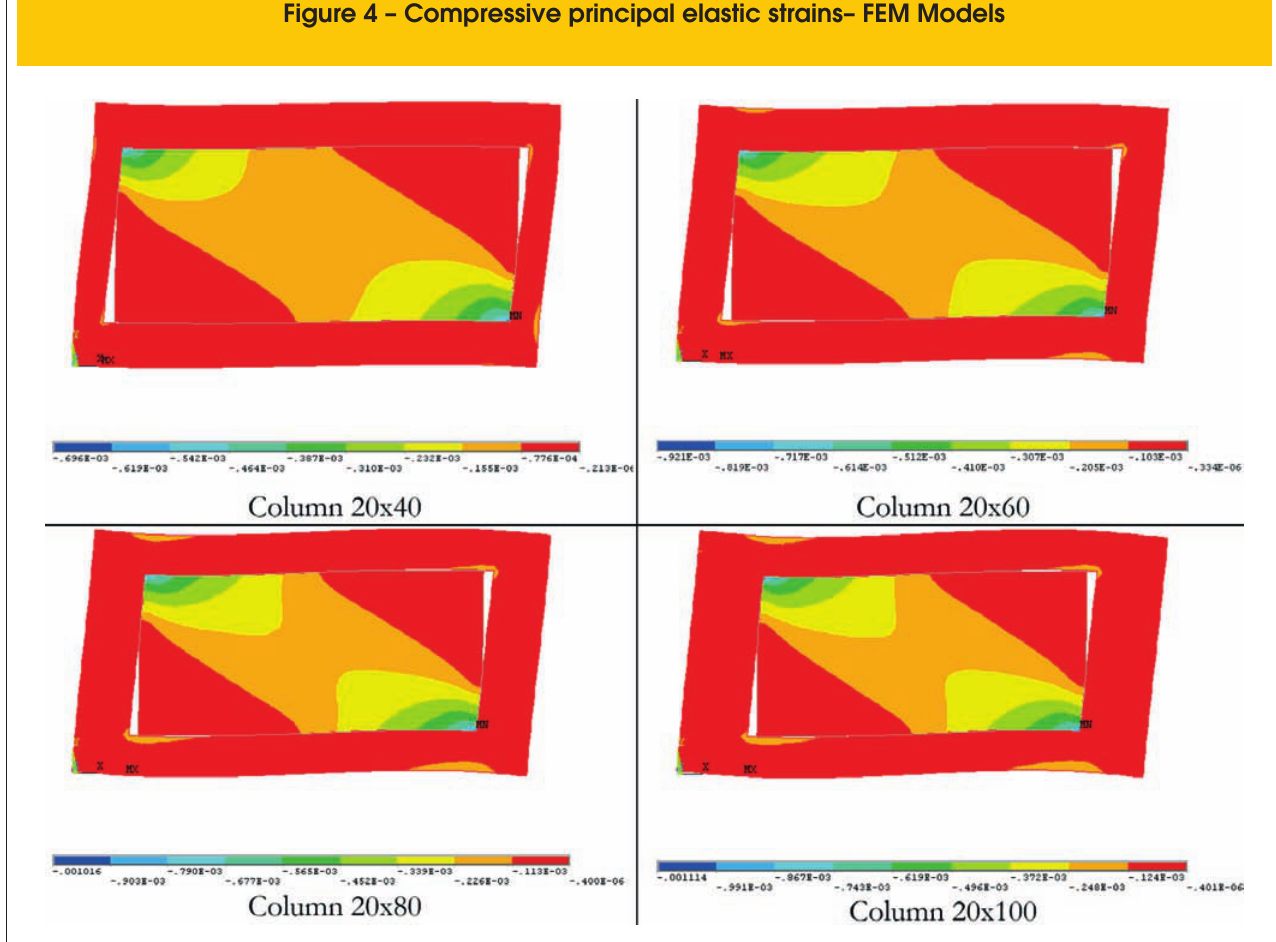
Figure 4 – Compressive principal elastic strains– FEM